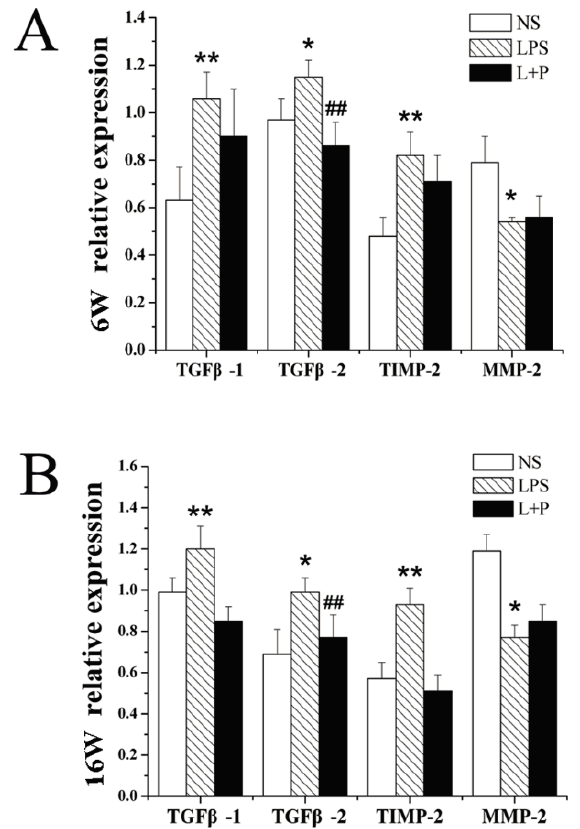
Figure 5. Effects of prenatal exposure to LPS or LPS + PDTC on mRNA expression in heart tissue from rat offspring. The mRNA expression of TGF β -1, TGF β -2, TIMP-2 and MMP2 in the heart of six- ( A ) and 16-week-old rats ( B ). n = 8. The values are presented as the means ± SD. * p < 0.05, ** p < 0.01 compared with the NS group; ## p < 0.01 compared with the LPS